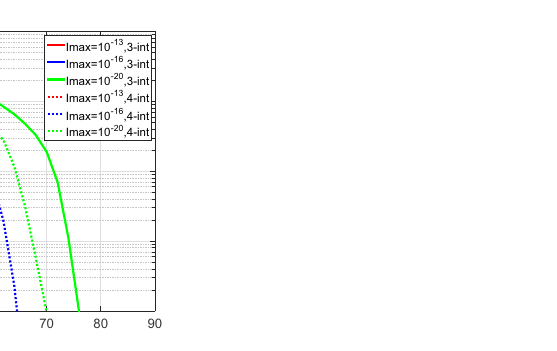
10 14 and various = 16 and consider various values for N . 10 − =